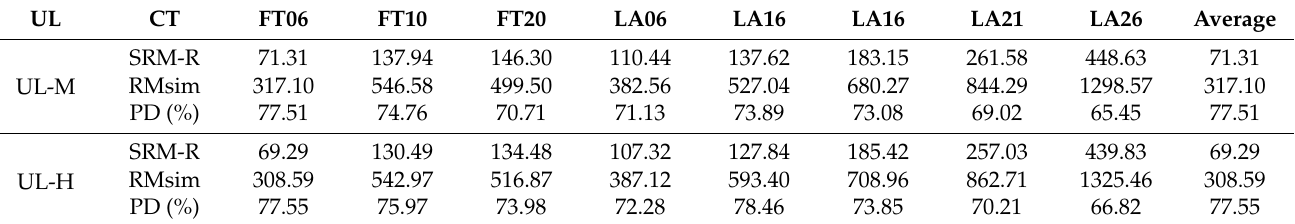
Table 6. The comparison of average computational time